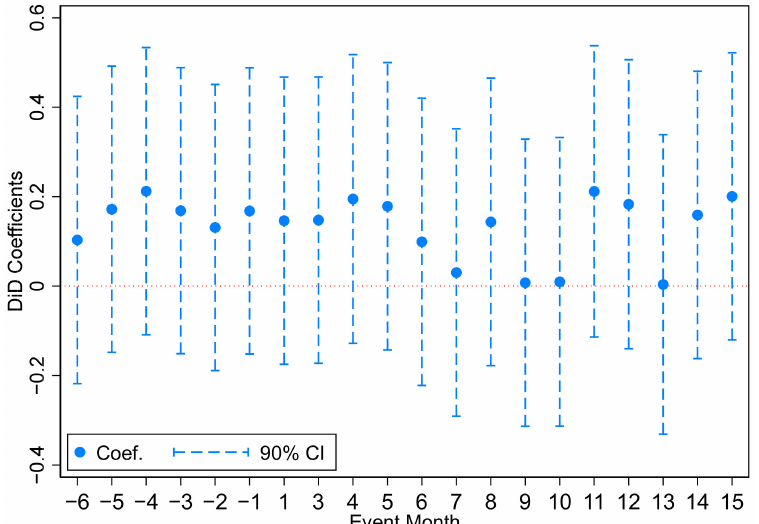
Figure 3. The impact of herding investors on price